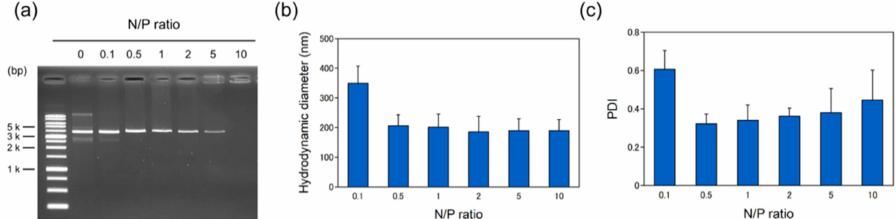
Figure 2. Characterization of pDNA complexes. ( a ) The electrical stability of the pDNA complexes. ( b ) Size of the pDNA complexes. ( c ) PDI of the pDNA complexes. Plasmid DNA (pBBR1MCS-2) was mixed with BP100-(KH) 9 at di ff erent N / P ratio, with a fixed amount of pDNA (1 µ g). Data are the mean ± SD of at least three